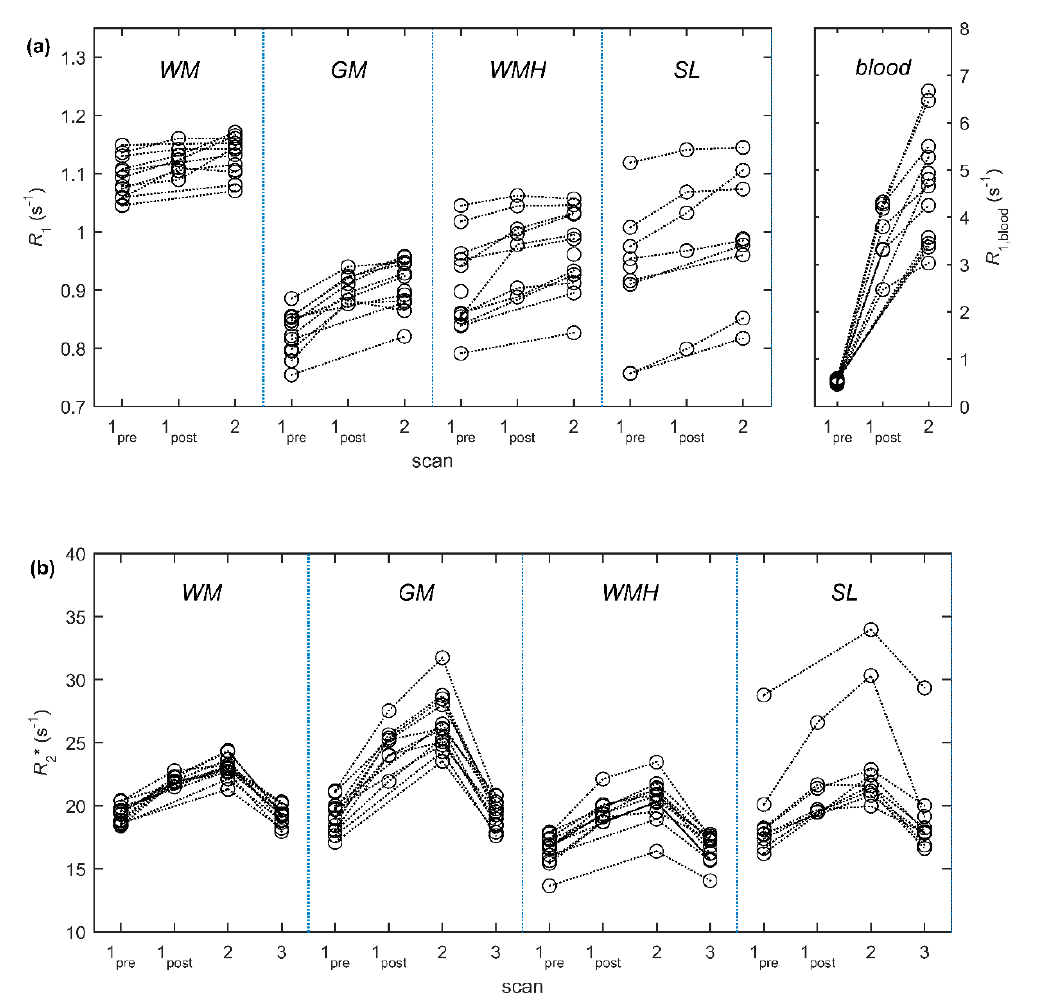
Figure 3. Median relaxation rates ( a ) R 1 and ( b ) R 2 * for each participant and tissue region at scan 1 pre (pre-USPIO), scan 1 post (immediately post-USPIO), scan 2 (24–30 h post-USPIO) and scan 3 (1-month post-USPIO, R 2 * only). Abbreviations: WM: normal-appearing white matter, GM: grey matter, WMH: white matter hyperintensities, SL: stroke lesion.